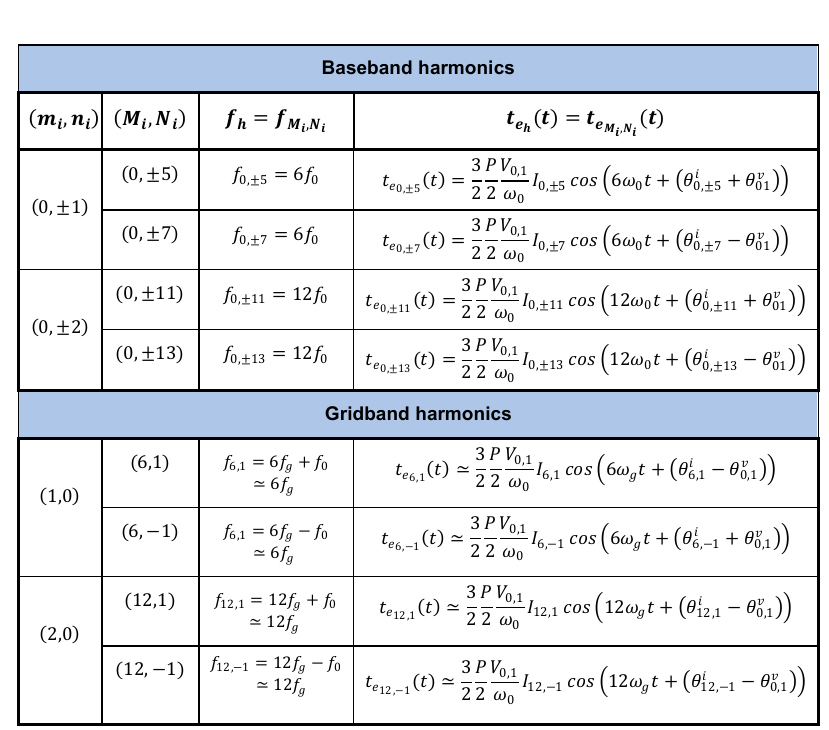
Baseband harmonics